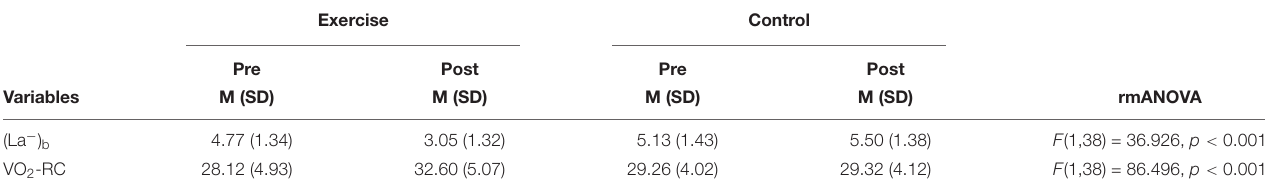
TABLE 2 | Aerobic fitness measures pre and post intervention by